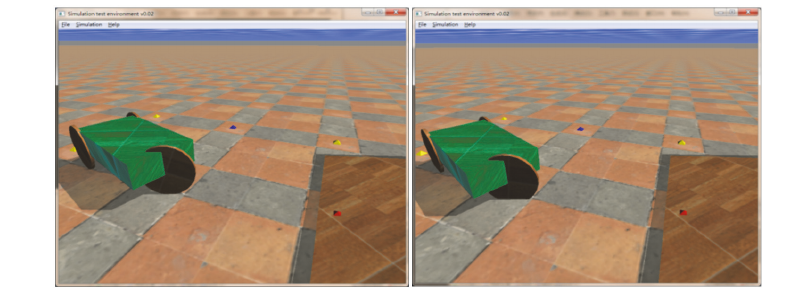
Figure 6: Comparison between preadjusted and adjusted penetration effects.